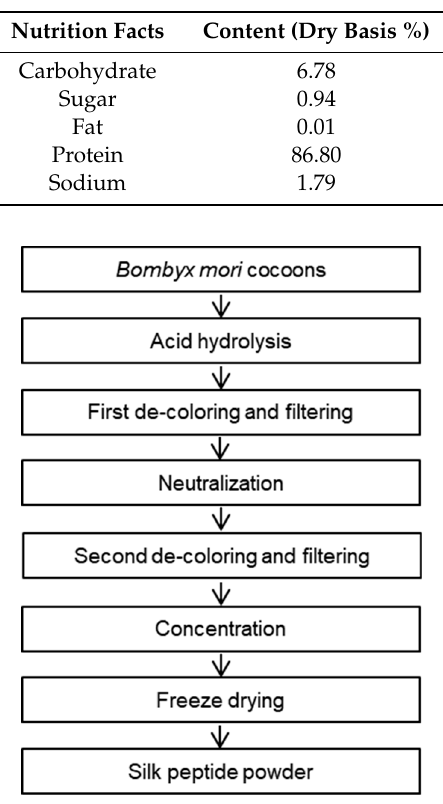
Figure 1. Scheme for the preparation of the silk peptide.